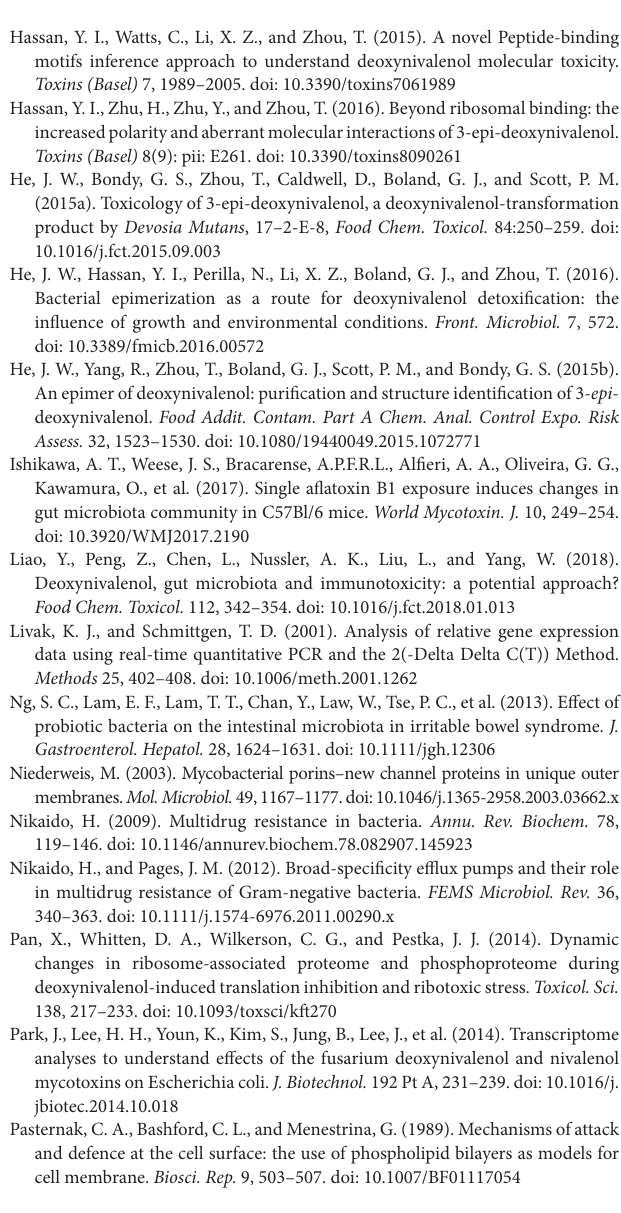
SUPPLEMENTARY TABLE 1 | A comprehensive list of Devosia mutans 17-2- E-8 transcripts that have been modulated (up or down-regulated) in response to deoxynivalenol (50 µg/ml) inclusion in bacterial growth